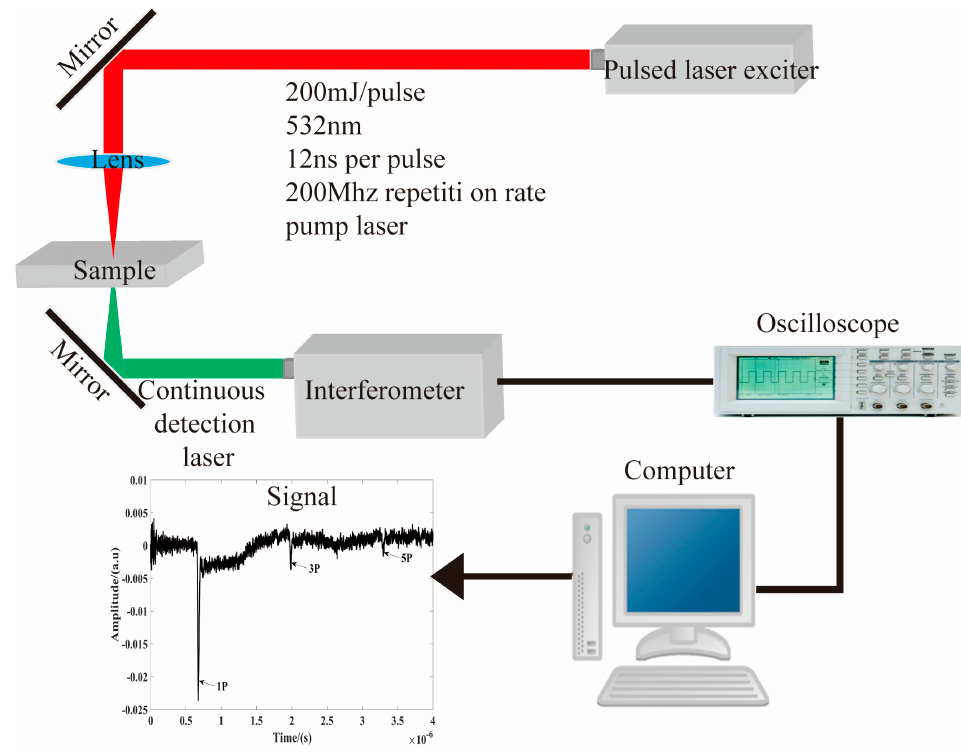
Figure 1. Laser Ultrasonic Laboratory Testing System.